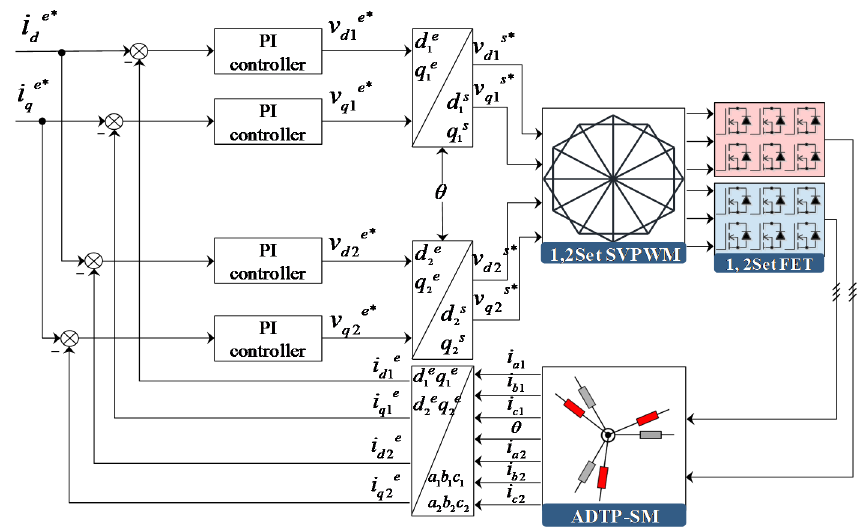
Figure 2. Current control block diagram applying Double dq transform of ADTP-SM.